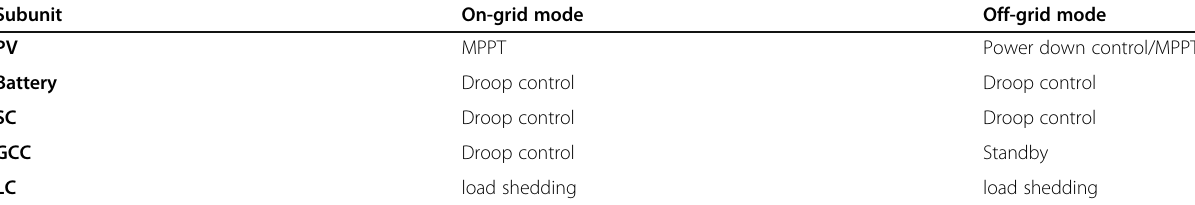
Table 1 Classification of each unit ’ s operational states